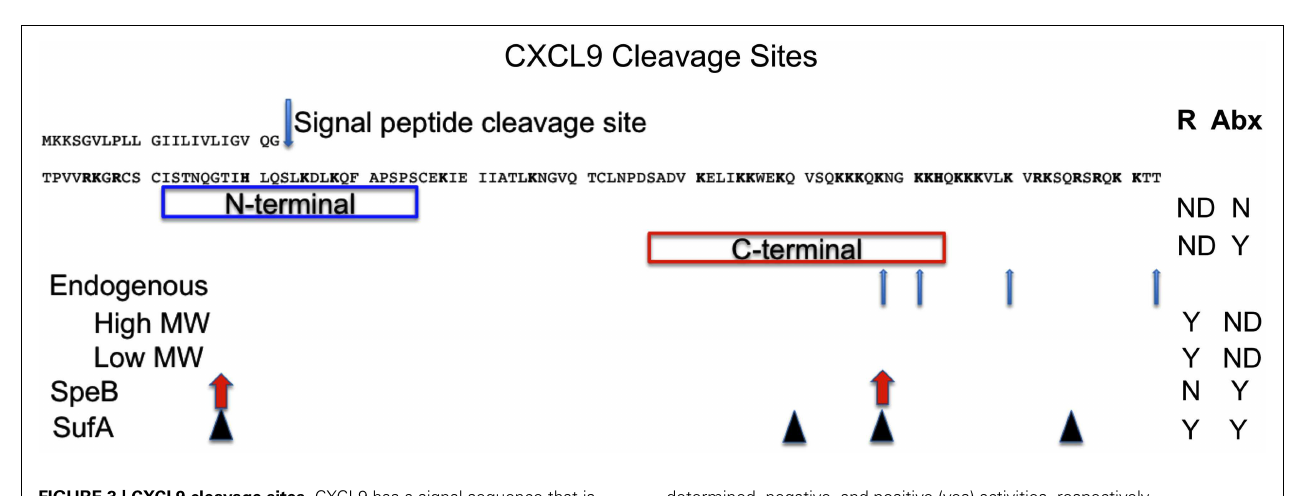
FIGURE 3 | CXCL9 cleavage sites. CXCL9 has a signal sequence that is cleaved before secretion. Blue box indicates an N-terminal peptide corresponding to predicted beta sheet secondary structure. Red box indicates a C-terminal peptide corresponding to predicted amphipathic alpha helix secondary structure. R and Abx represent CXCR3 receptor activation and antibiotic activities, respectively. ND, N, andY, denote not